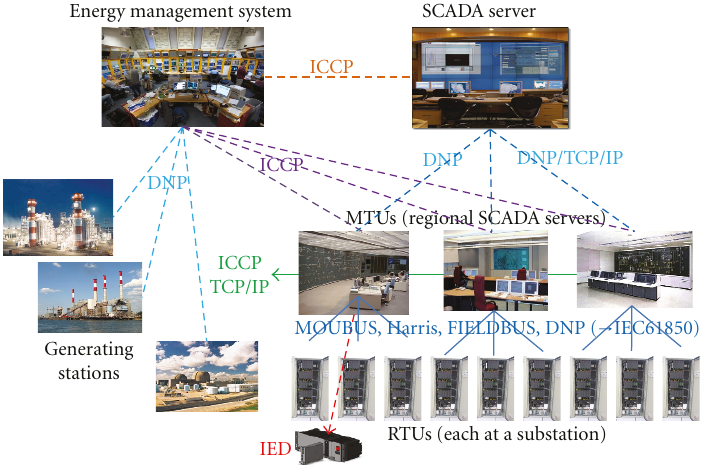
Figure 32: Data exchange between SCADA and EMS.